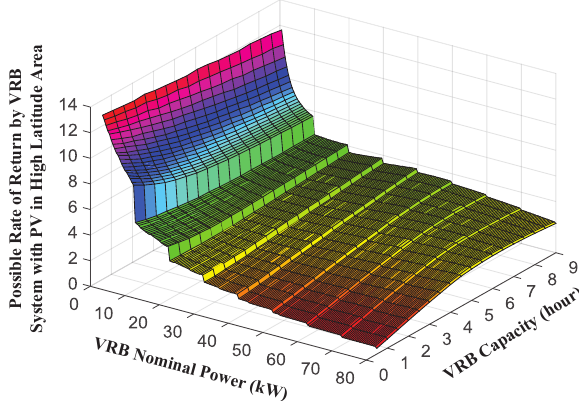
Figure 16. Net economic benefit earned by the VRB system with PV in a high latitude area (in thousand dollars).